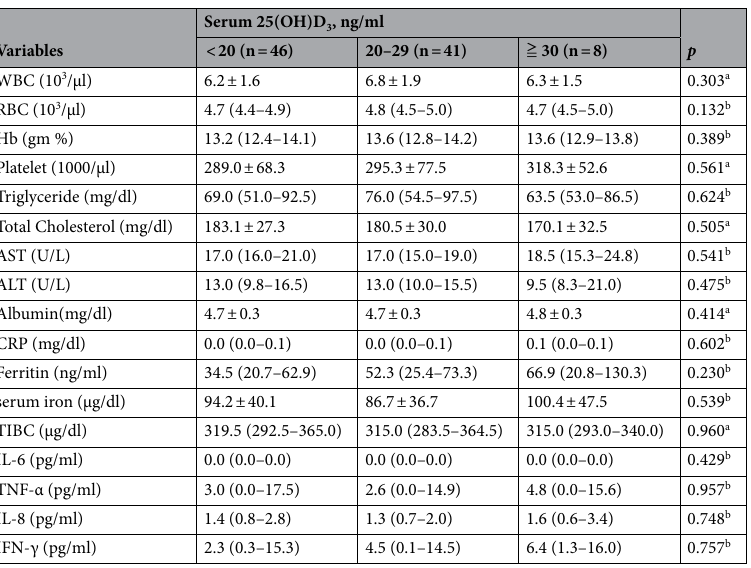
Table 4. Participant biochemistry according to 25(OH)D 3 concentrations. WBC, white blood cell count; RBC, red blood cells; Hb, hemoglobin; AST, aspartate aminotransferase; ALT, alanine aminotransferase; CRP, C-Reactive Protein; TIBC, total iron binding capacity; IL-6, Interleukin-6; TNF-α, tumor necrosis factor-α; IL-8, interleukin-8; IFN-γ, interferon-γ. * p -value < 0.05. The power after calculation and analysis after the event: the number of subjects is 95 (n = 95), and the ANOVA test is carried out in three groups, and the calculated power is 0.6550386. a Data were continuous and presented as mean ± SD using ANOVA. b Data were continuous and presented as median (IQR) using Kruskal–Wallis test.